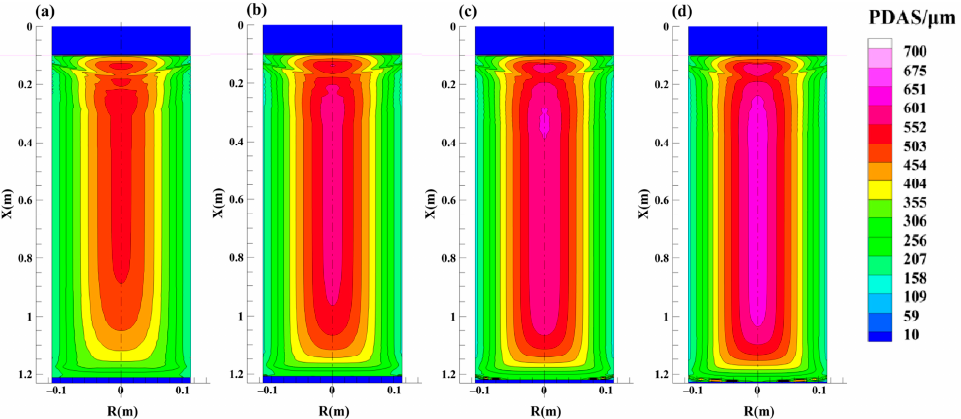
Figure 10. Distribution of PDAS at varying melting rate: ( a ) 90 kg/h, ( b ) 120 kg/h, ( c ) 150 kg/h and ( d ) 180 kg/h.